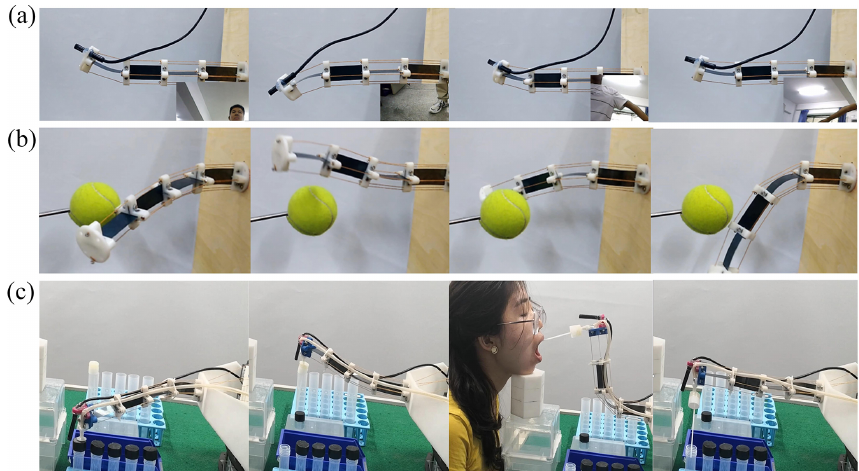
Figure 10. (a) The up–down and left–right movements of the tip of the robot are realised by driving its fourth and third bending sections, respectively. (b) The robot moves around a ball flexibly. (c) When the tip of the robot is equipped with a suction cup and a camera, the robot can be used for nucleic acid detection. It finishes the preparatory work, grabs a cotton swab, takes a sample, puts the pharyngeal swab into a test tube, and breaks it